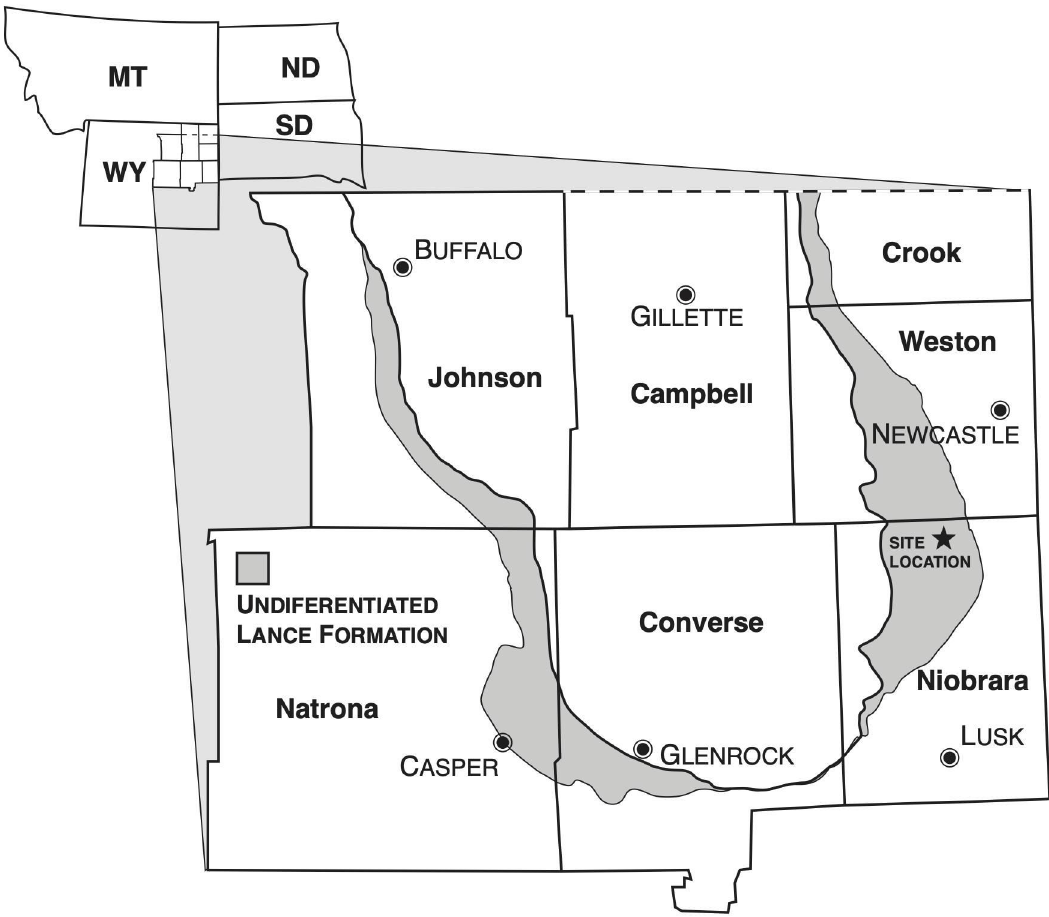
Fig 1. Hanson Ranch Bonebed site on a map of surface outcrops of the Cretaceous Lance